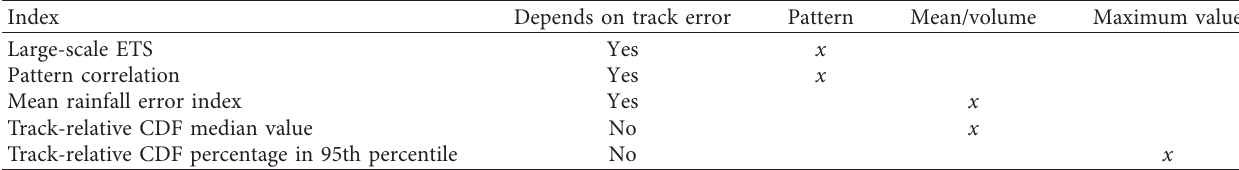
Table 4: Indices calculated to evaluate predictive skills of the system.